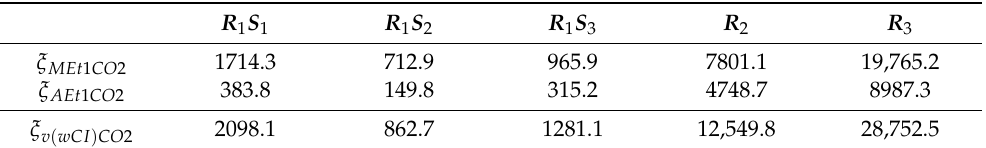
Table 18. Distribution of total carbon emissions generated by main and auxiliary engines during t 1 (in kgCO 2